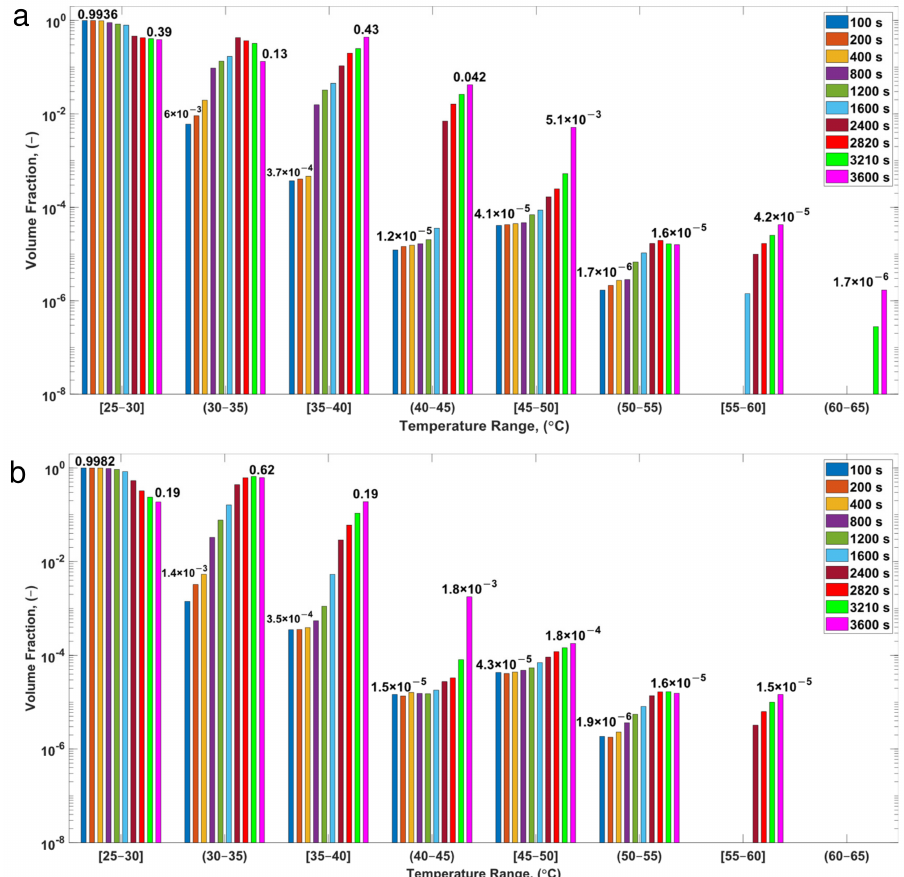
Figure 18. Temporal variation in volume fractions on a logarithmic scale with respect to the tempera- ture range in the suppression pool for aspect ratios of ( a ) 0.5 (Case J) and ( b ) 2.0 (Case